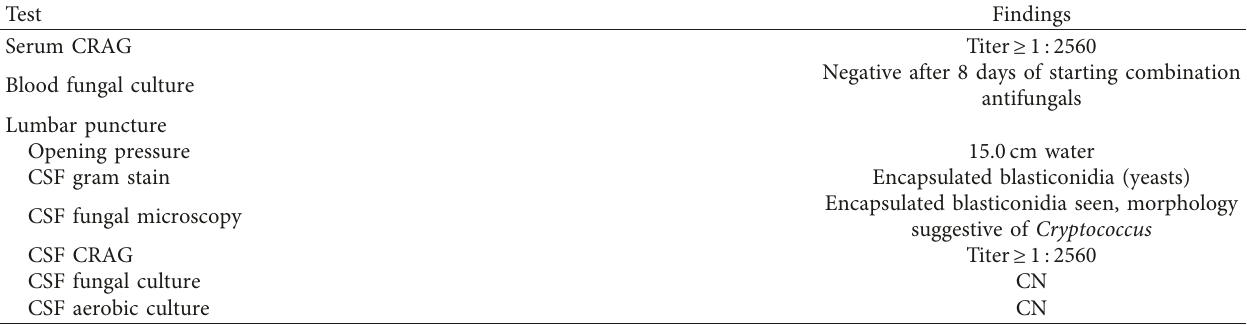
Table 4: Repeated microbiological investigations after 10days of